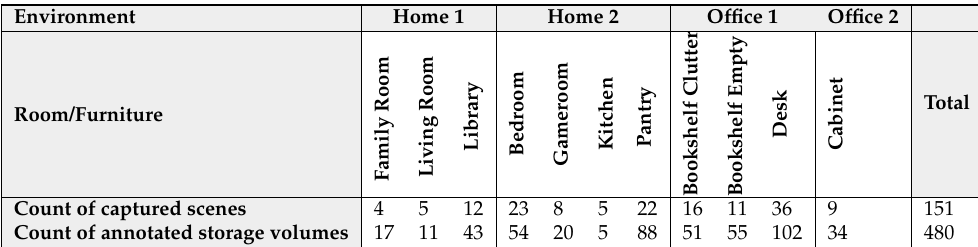
Table 3. Number of captured scenes and annotated storage volumes in the real dataset. Environment